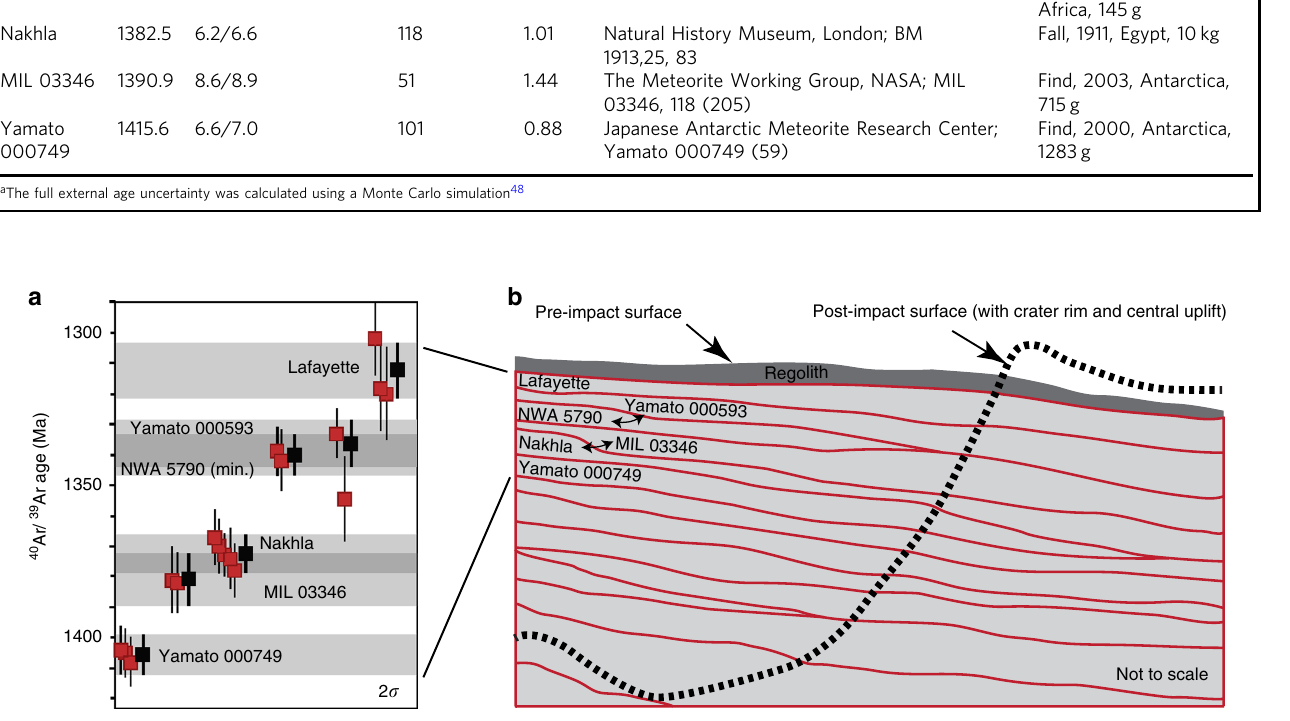
Fig. 6 Stratigraphic model for the nakhlite meteorites. a Summary of 40 Ar/ 39 Ar age data. Each meteorite has multiple aliquots with highly reproducible plateau ages ( red squares ). Bold black squares and horizontal grey bars represent weighted mean ages. The 40 Ar/ 39 Ar results indicate that the nakhlites were erupted in at least four temporally discrete eruptions, with volcanic activity spanning 93 ± 12 Ma. All uncertainties are 2 σ . b Schematic cross-section for a layered lava fl ow sequence, with nakhlite stratigraphic relationships and outline of post-impact